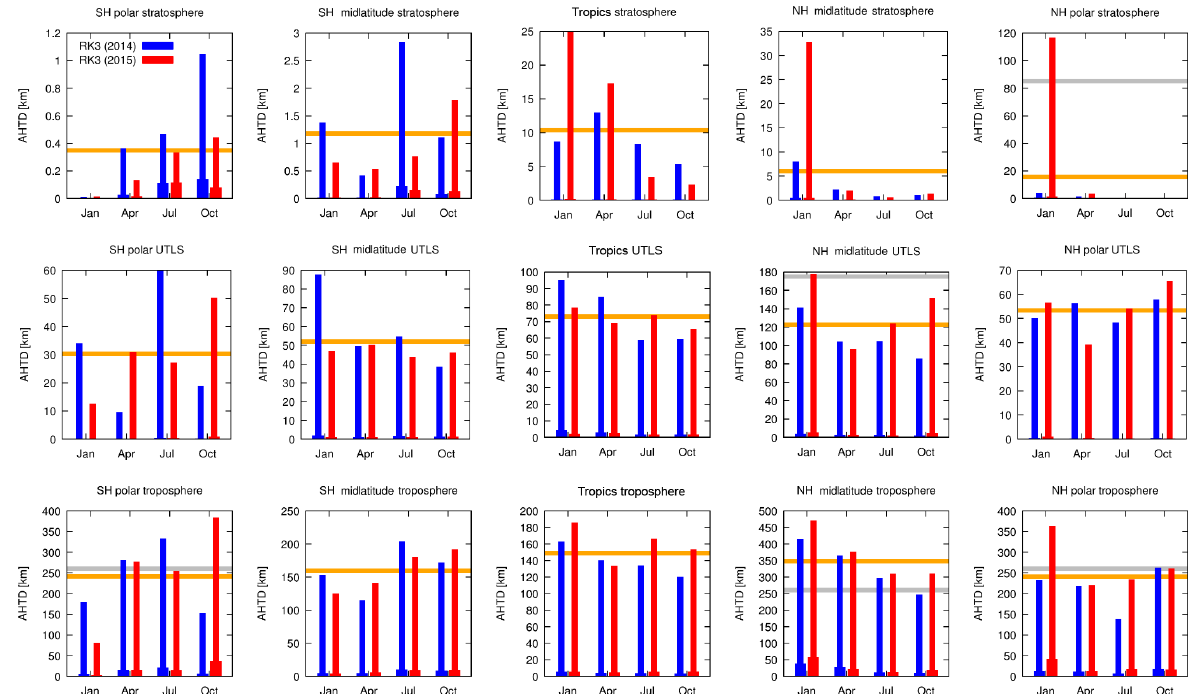
Figure 5. Mean (thin bars) and median (thick bars) horizontal transport deviations after 10 days of simulation time in different regions for the RK3 method and 120s time step. Orange lines show the averages of the four months (January, April, July, and October) and both years (2014 and 2015). Grey lines show error limits based on diffusion.